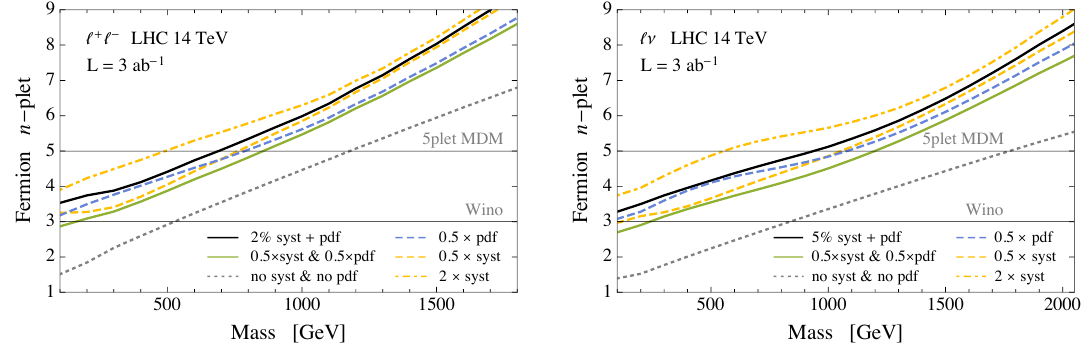
Figure 4 . Dependence of the 95% CL exclusion bounds on Majorana fermion multiplets at the HL-LHC on the PDF uncertainties and on the additional systematic errors. The left and right panels show the bounds from the ‘ + ‘ (cid:0) and ‘(cid:23) channels respectively. The solid black lines give the bounds for our benchmark systematic errors. The dashed (dot-dashed) yellow lines show how the bound changes if the additional systematic uncertainties are halved (doubled). The dashed blue lines show how the bounds are modi(cid:12)ed by halving the PDF uncertainty. The solid green lines give the bound with all systematic uncertainties halved. Finally the dotted grey lines correspond to the bounds with no systematic and PDF